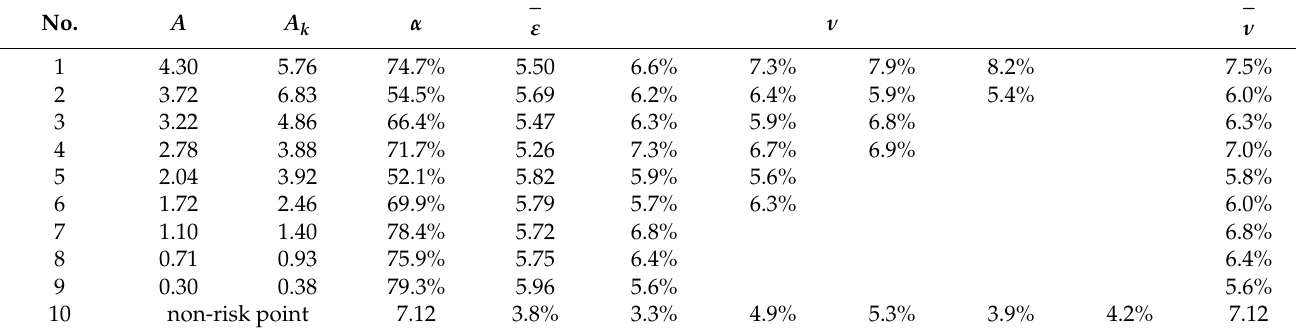
Figure 11. Distribution of connected risk areas in unit 1. Table 1. Regional indicators of connected risk areas.